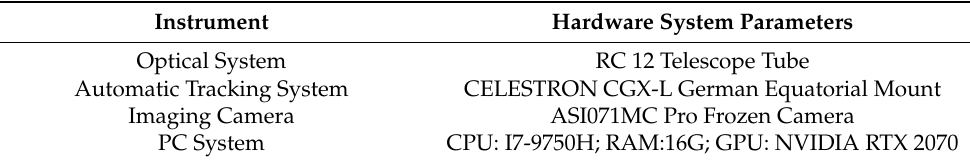
Figure 6. Cassegrain optical observation system. Table 3. Main technical specifications of the observation system.